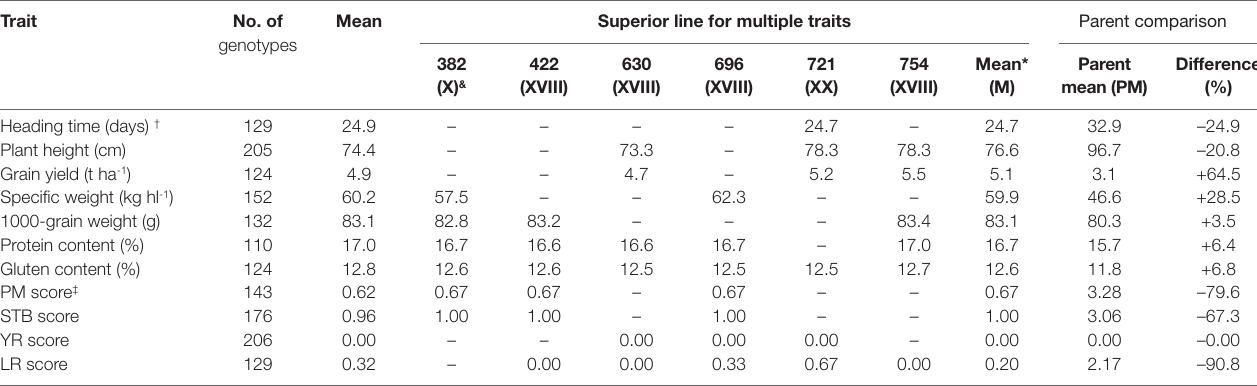
TABLe 7 | Number and means of genotypes with superior values for each of the 11 agronomic and disease-resistance traits, and superior lines for multiple traits, as identified by cluster analysis, with comparisons to parent values also given.